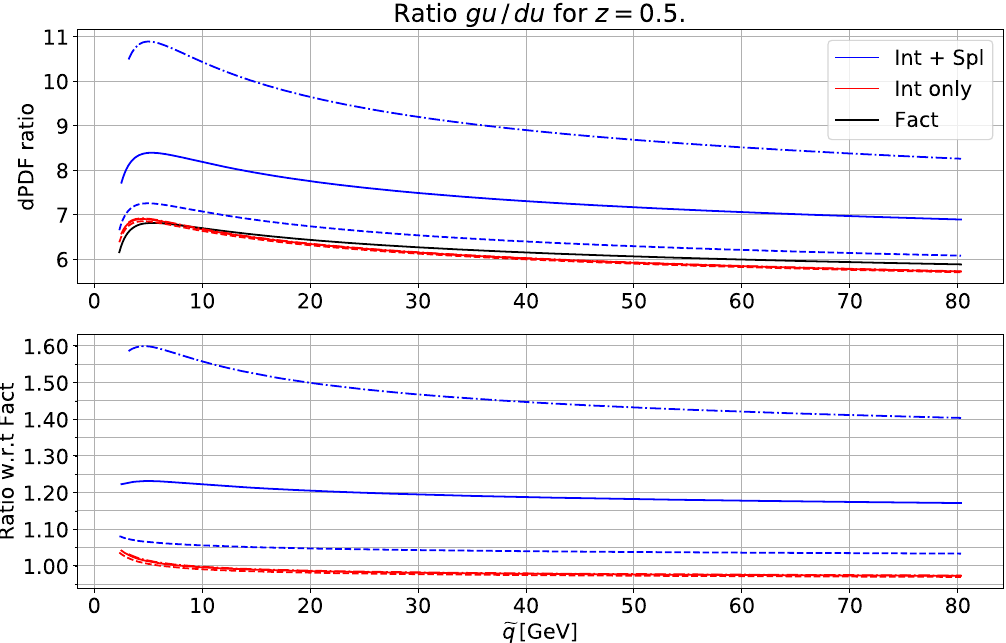
Figure 14 . Ratio of dPDFs as a function of the evolution variable ~ q for di(cid:11)erent setups. The ratio (cid:22)d with a u quark acting as a spectator. The values corresponds to the backward branching g ! of the momentum fractions are z = 0 : 5 and x 1 ; 2 = m W = p s . The dashed, solid and dashed-dotted lines correspond to the values y = 2 GeV (cid:0) 1 , y = 1 GeV (cid:0) 1 and y = 0 : 5 GeV (cid:0) 1 respectively. The setup Fact is the reference in the ratio